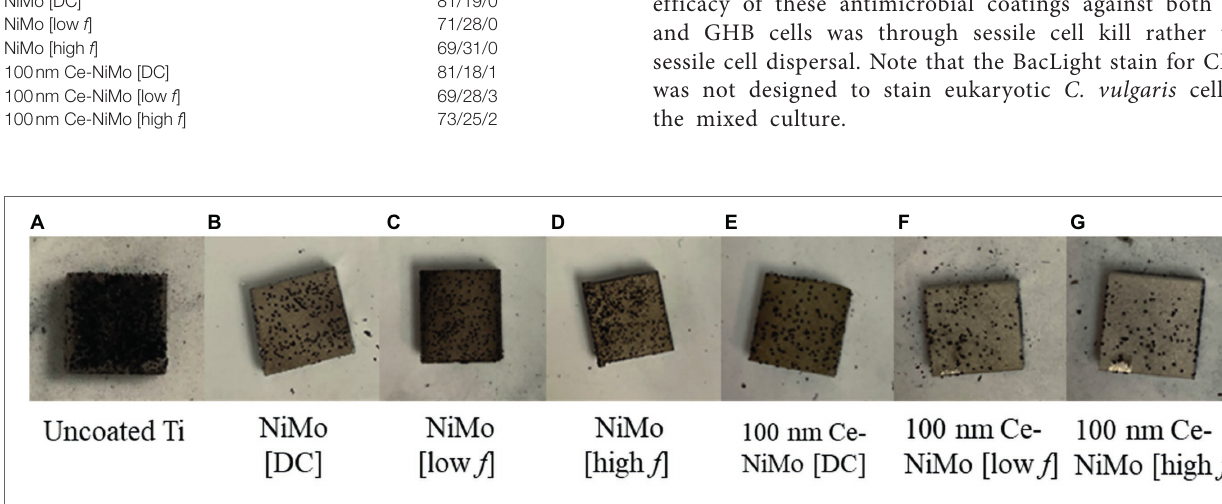
FIGURE 3 | Uncoated Ti coupon (1 cm 2 ; A ), Ti coupon surfaces with NiMo coatings made with different conditions (B) NiMo [DC], (C) NiMo [low f ], and (D) NiMo [high f ], Ti coupon surfaces coated with 100 nm Ce in NiMo coatings (D) 100 nm Ce-NiMo [DC], and (E) 100 nm Ce-NiMo [low f ], and (F) 100 nm Ce-NiMo [high f ] (G) after 21-day SRB incubation at 37 ° C.